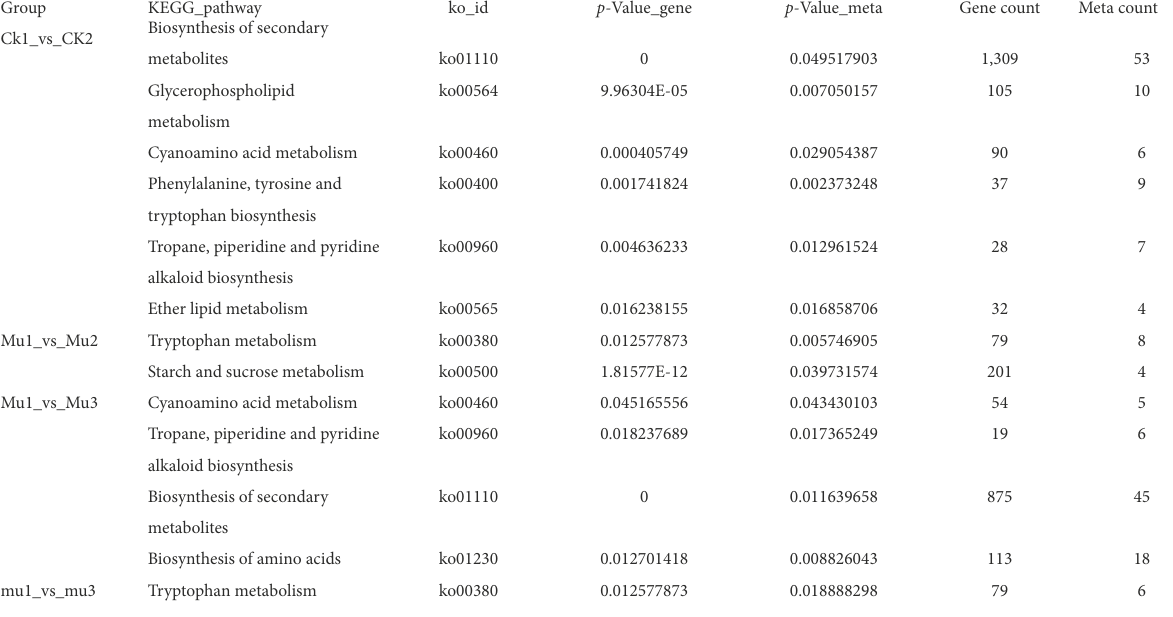
TABLE 1 Co-regulated pathways according to the metabolome and transcriptome analysis.